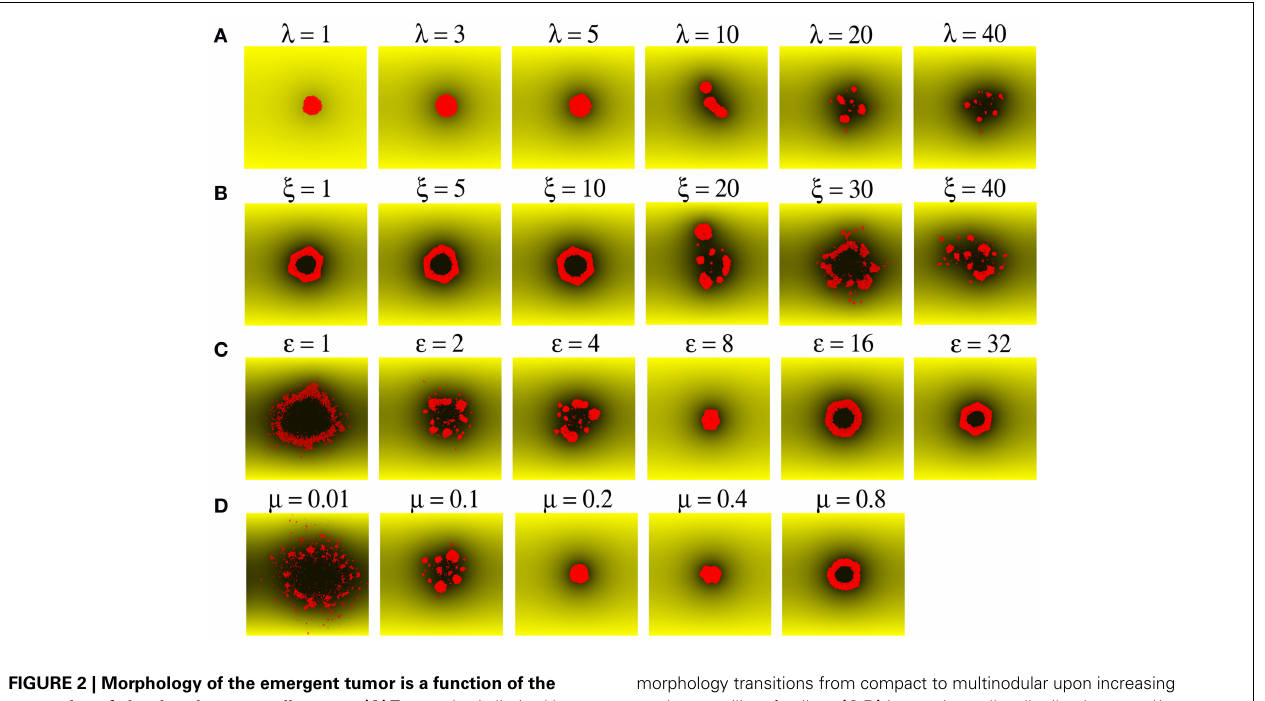
FIGURE 2 | Morphology of the emergent tumor is a function of the properties of simulated cancer cell agents. (A) Tumor size is limited by λ , the rate of nutrient consumption by cancer cells (shown as small red circles). Nutrient concentration in a region is indicated by the shade of yellow color, with black indicating zero concentration. (B) Tumor